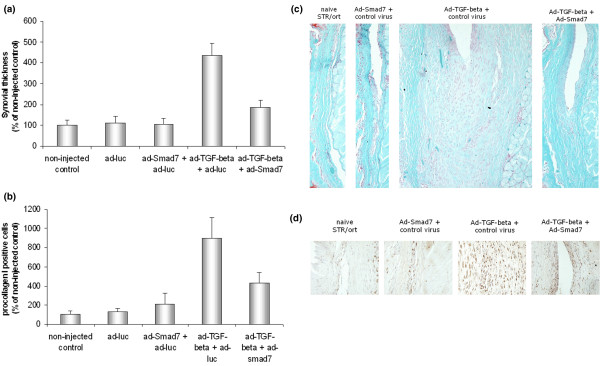
Blocking of transforming growth factor-β (TGF-β)-induced synovial fibrosis in osteoarthritits (OA). STR/ort mice (4 weeks old) were injected intra-articularly with Ad-TGF-β combined with Ad-Smad7 or Ad-luciferase (Ad-luc) and injected again 2 weeks later. Two weeks after the last injection, knee joints were isolated for histology and synovial fibrosis was assessed. Synovial thickness was determined by measuring the width of the synovium opposite the growth plates in the femur. (a) Synovial thickness had increased significantly after adenoviral TGF-β overexpression (p < 0.005). More than 50% of this increase in width was prevented by simultaneous expression of Smad7 (p < 0.005). The number of procollagen type I-expressing cells (b) had increased as well after exposure to TGF-β (p < 0.0005). This was also inhibited by more than 50% by co-expression of Smad7. Histological representations of the measurements give an indication of actual thickness (c) and procollagen positive cells (d) Error bars display standard error.